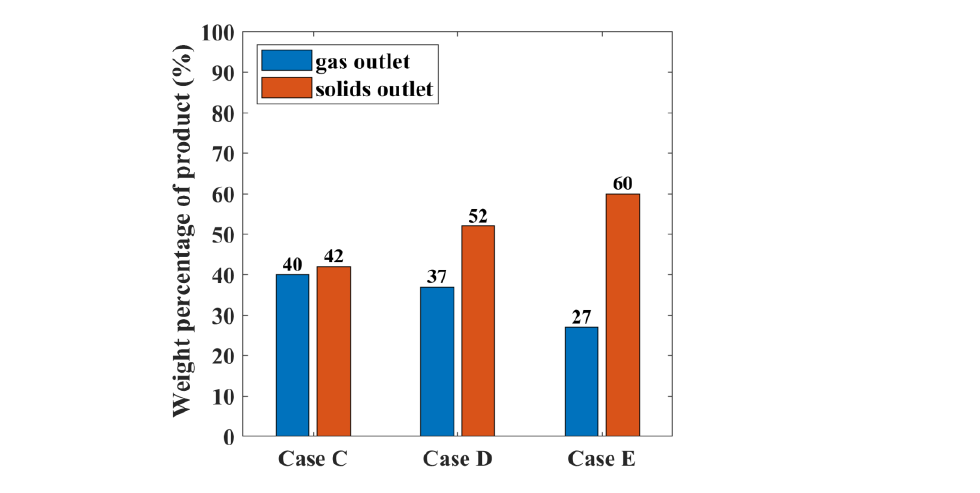
Figure 12. Comparison of weight percentage (%) of product recovered at the outlets for cases C–E.